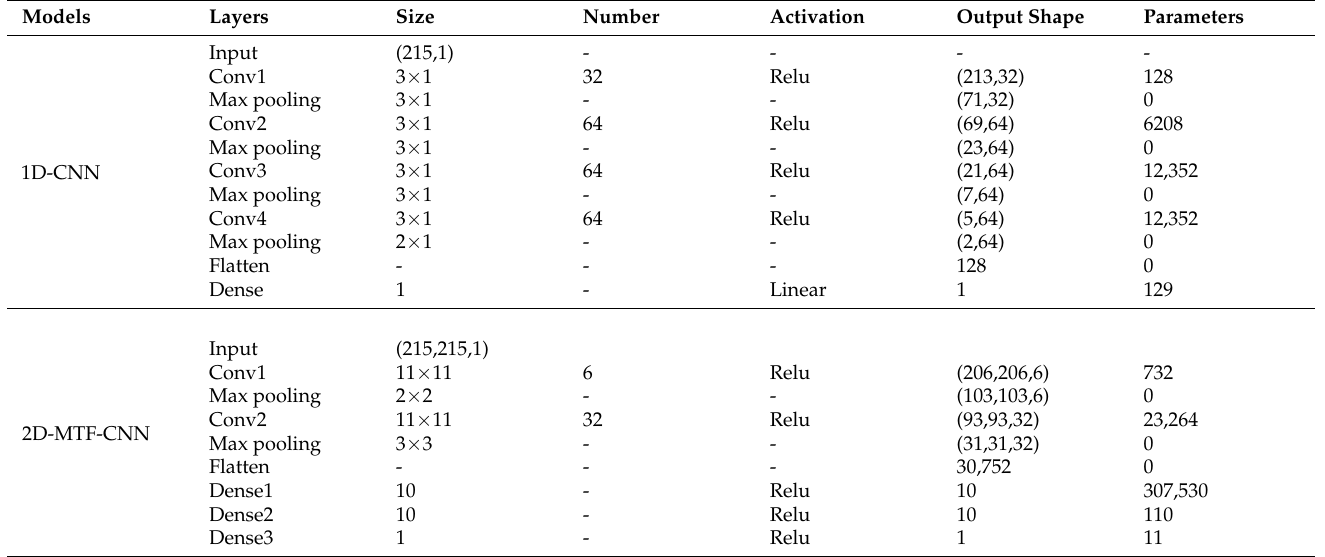
Table 2. The structures and parameters of the 1D-CNN and 2D-MTF-CNN